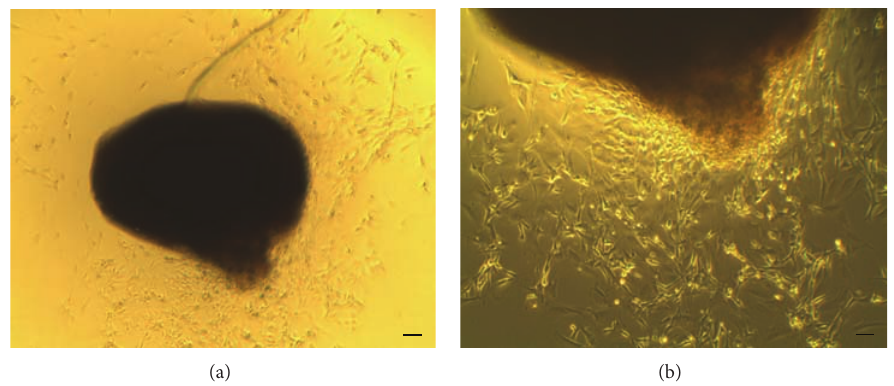
Figure 1: Facial nerve reactive explants. (a): 4x; (b): 10x. Scale: 100 𝜇 m.